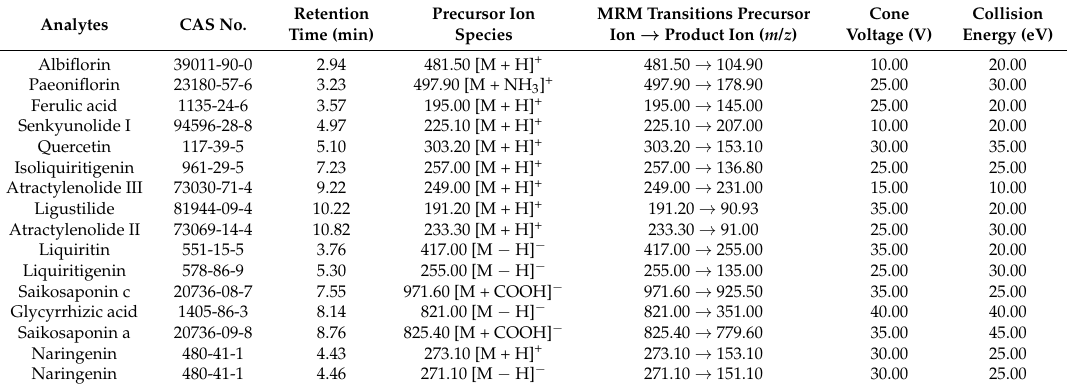
Table 6. Precursor/product ion pairs and parameters for MRM of compounds used in this study. Analytes CAS